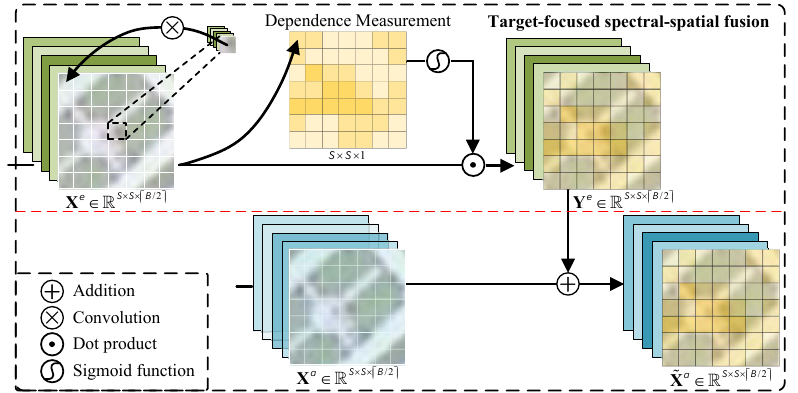
Figure 4. Schematic illustration of the object-guided spectral–spatial fusion mechanism